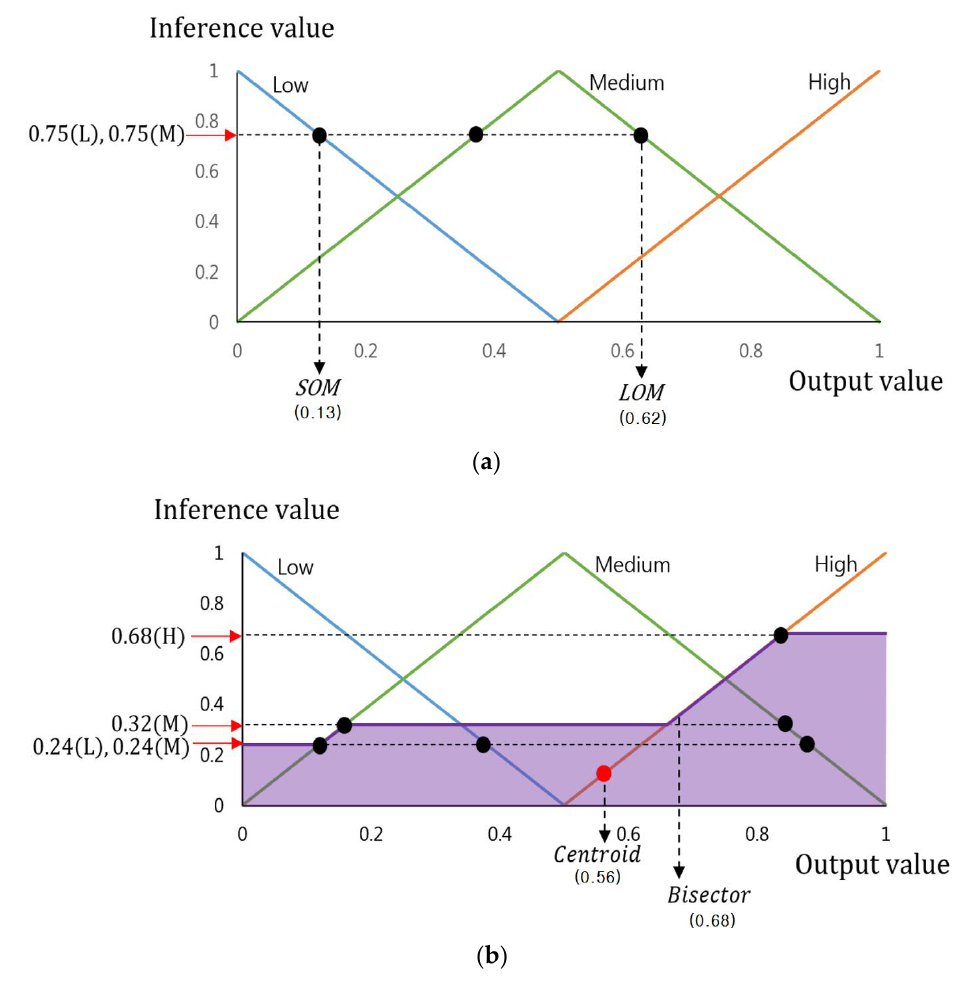
Figure 5. An example of Output Value depending on various Defuzzification methods ( a ) Output values by SOM and LOM methods with the inference values by Max rule of Table 3. ( a ) Output values by Centroid and Bisector methods with the inference values by Min rule of Table 4.